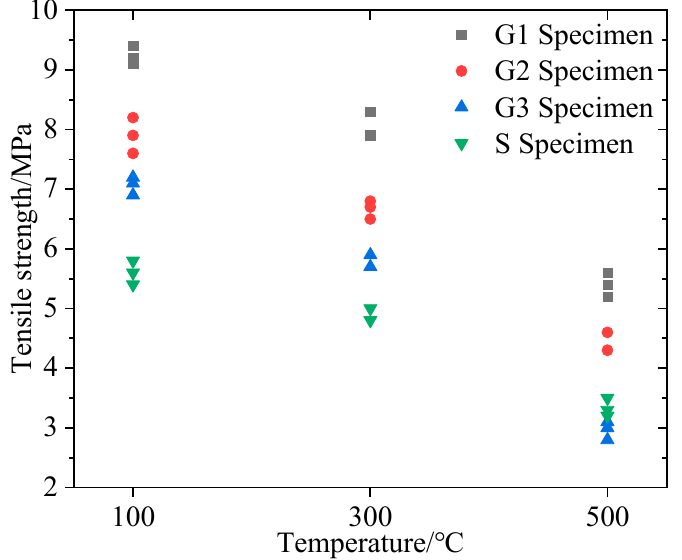
Figure 13. Variation of tensile strength with specimen lithology and temperature.